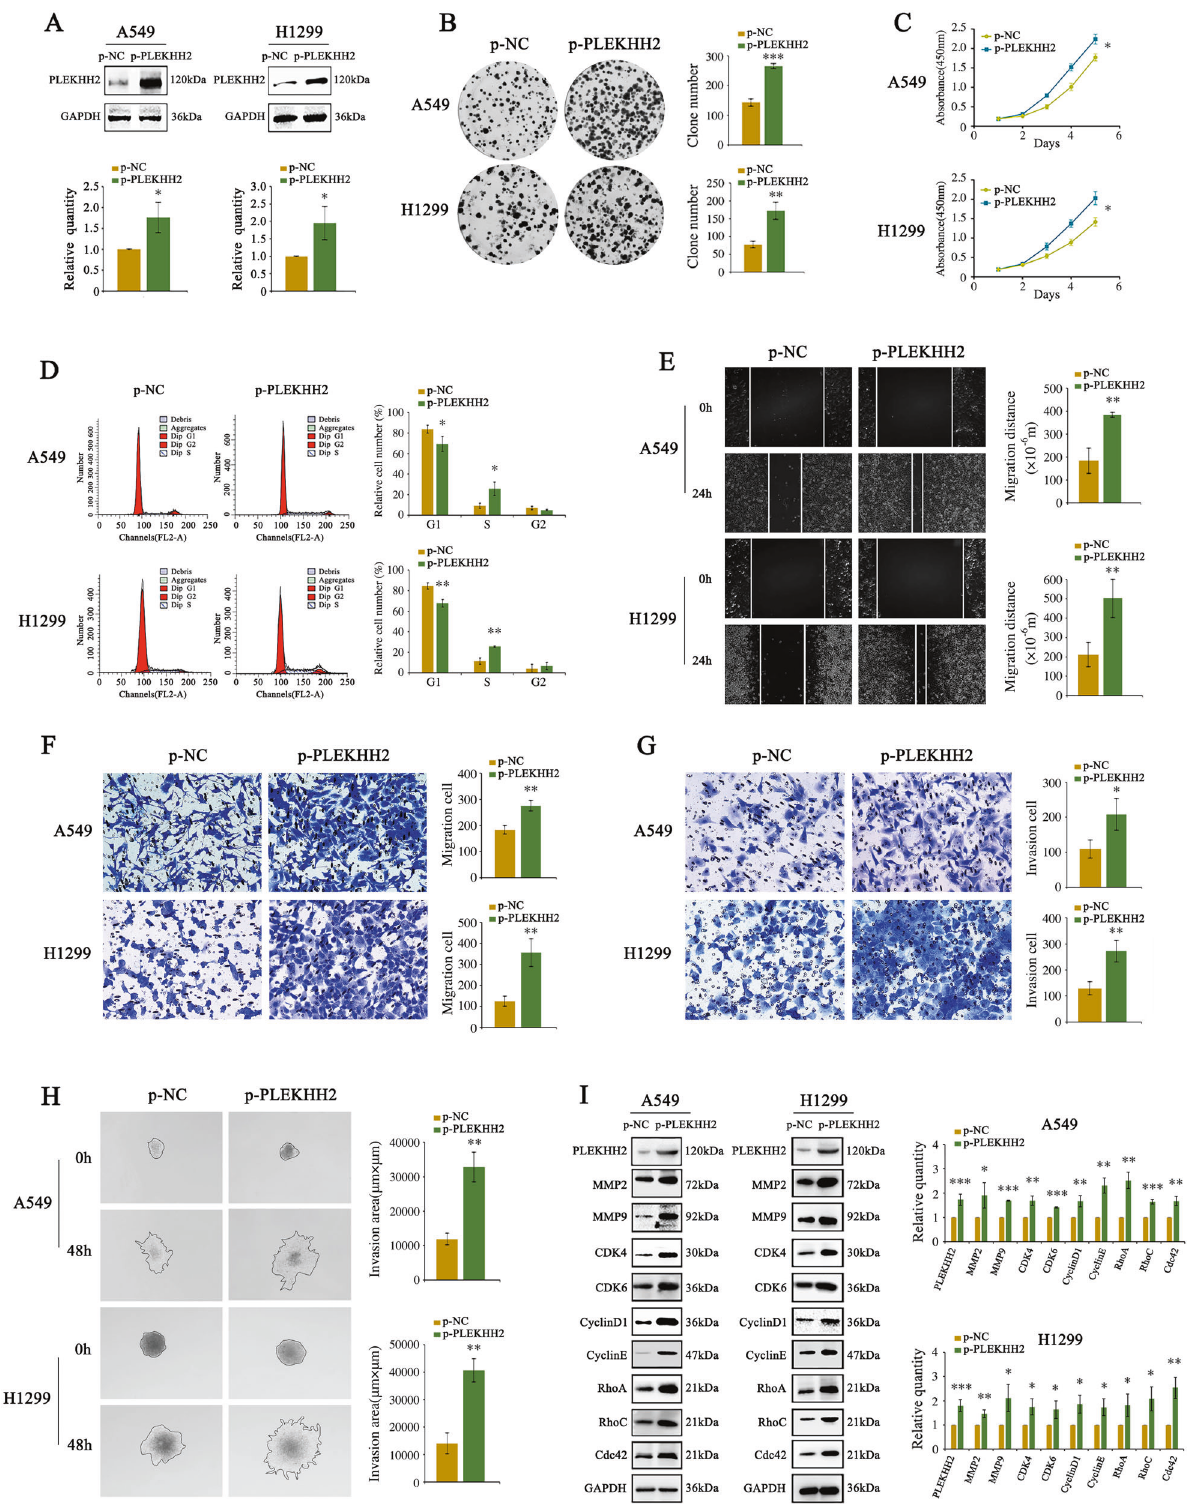
expression ( P = 0.014, Fig. 1B, Supplementary Table 2). Western blot analysis (Fig. 1C, D), and immuno fl uorescence (Fig. 1E) were then performed in lung cancer cell lines, which showed increased PLEKHH2 expression compared to that in HBE cells. These results suggest that PLEKHH2 acts as a tumor promoter in